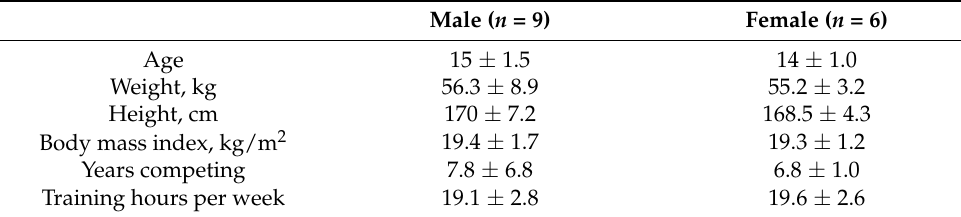
Table 1. Participant characteristics a